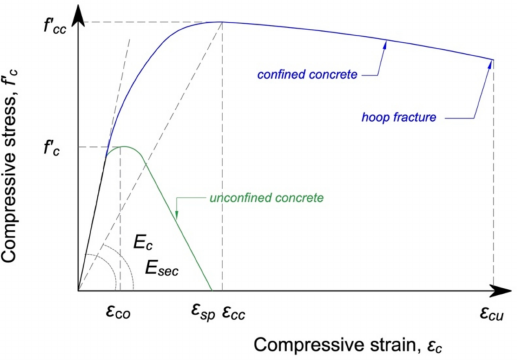
Figure 10. Stress–strain relationship of confined and unconfined concrete material models used in inelastic beam–column